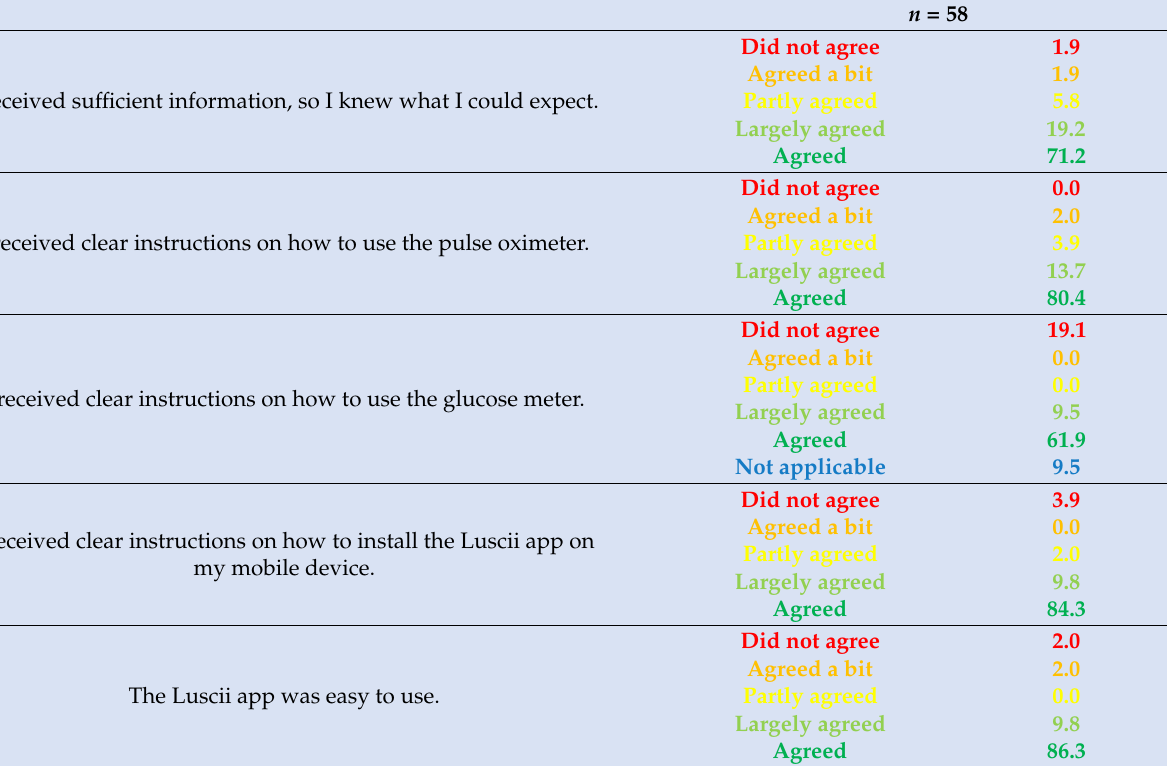
Table 3. Patient experience and